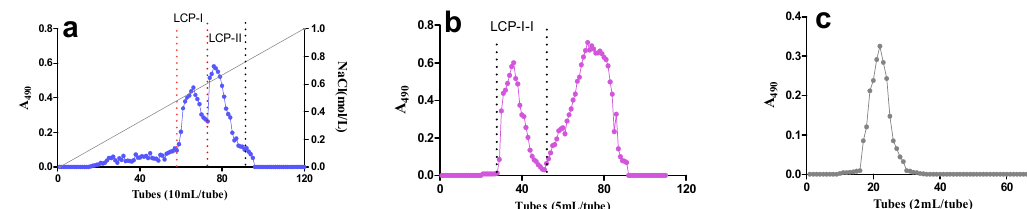
Figure 1. The carbohydrate elution profiles were monitored using the phenol–sulfuric acid assay (A490 is the absorbance at 490 nm). ( a ) Ion exchange chromatography elution profile of fraction L. chuanxiong polysaccharide (LCP); ( b ) Gel filtration elution profile of fraction LCP-I; ( c ) Size exclusion chromatography elution profile of fraction LCP-I-I. A490 stands for absorbance at 490 nm as described in phenol–sulfuric acid method.